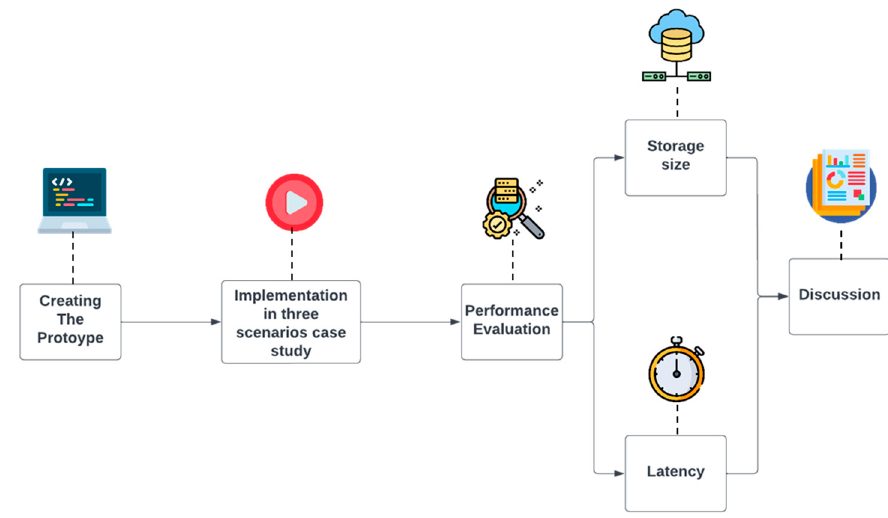
Figure 4. Research methodology procedures.